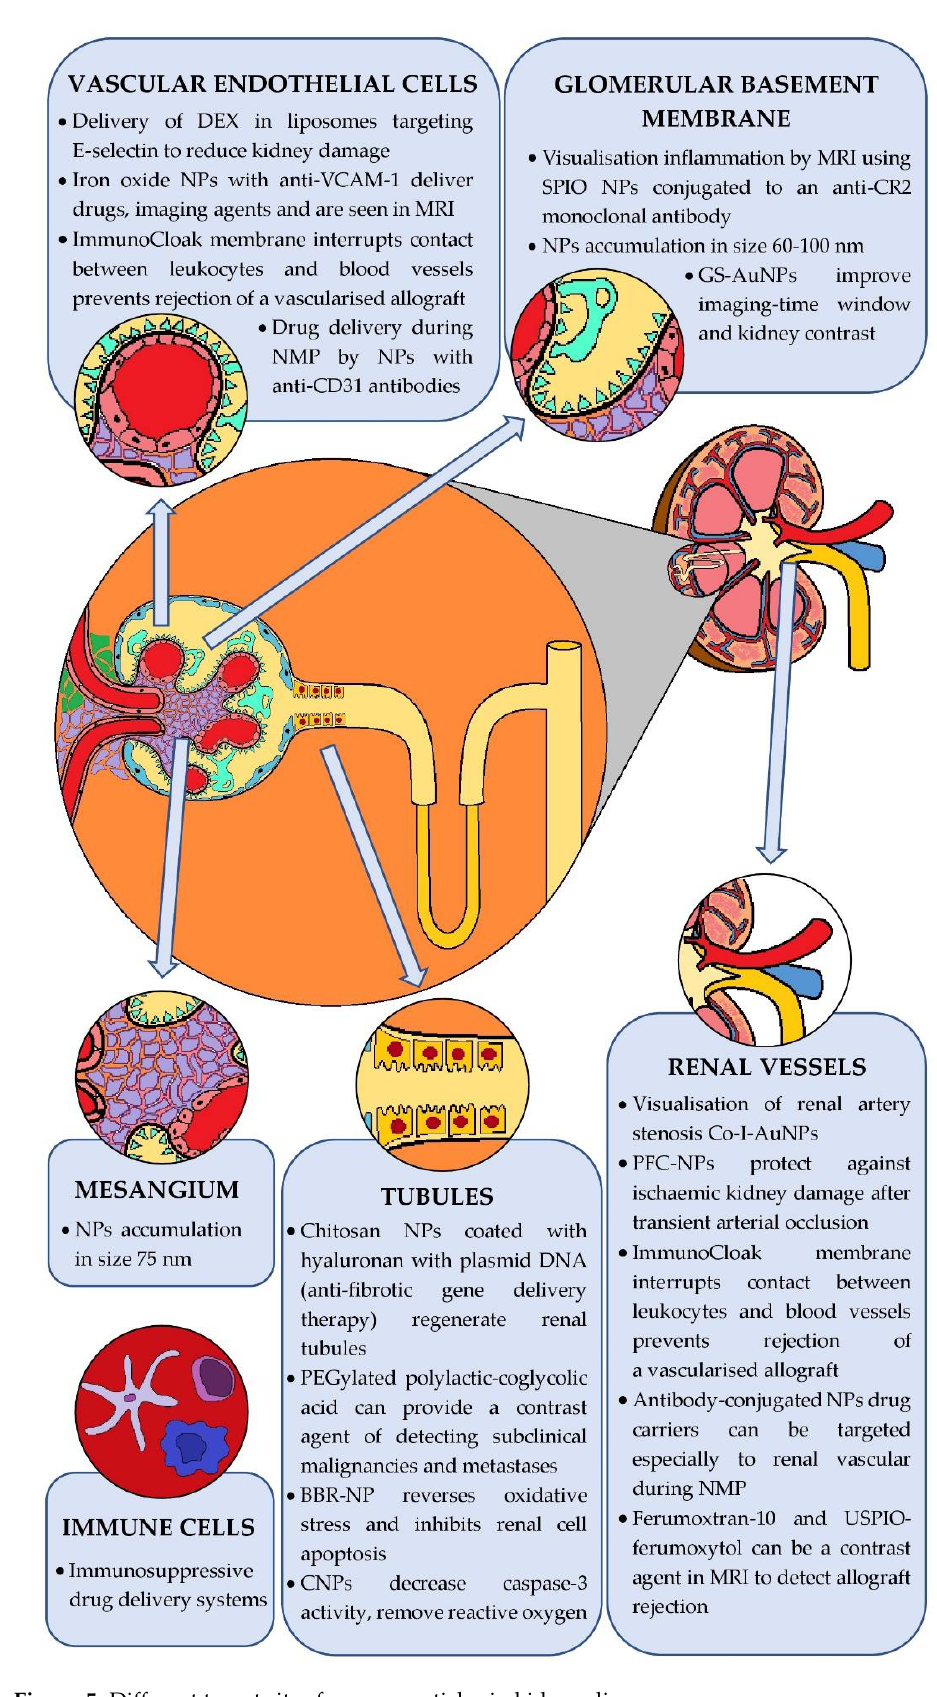
Figure 5. Different target sites for nanoparticles in kidney diseases.